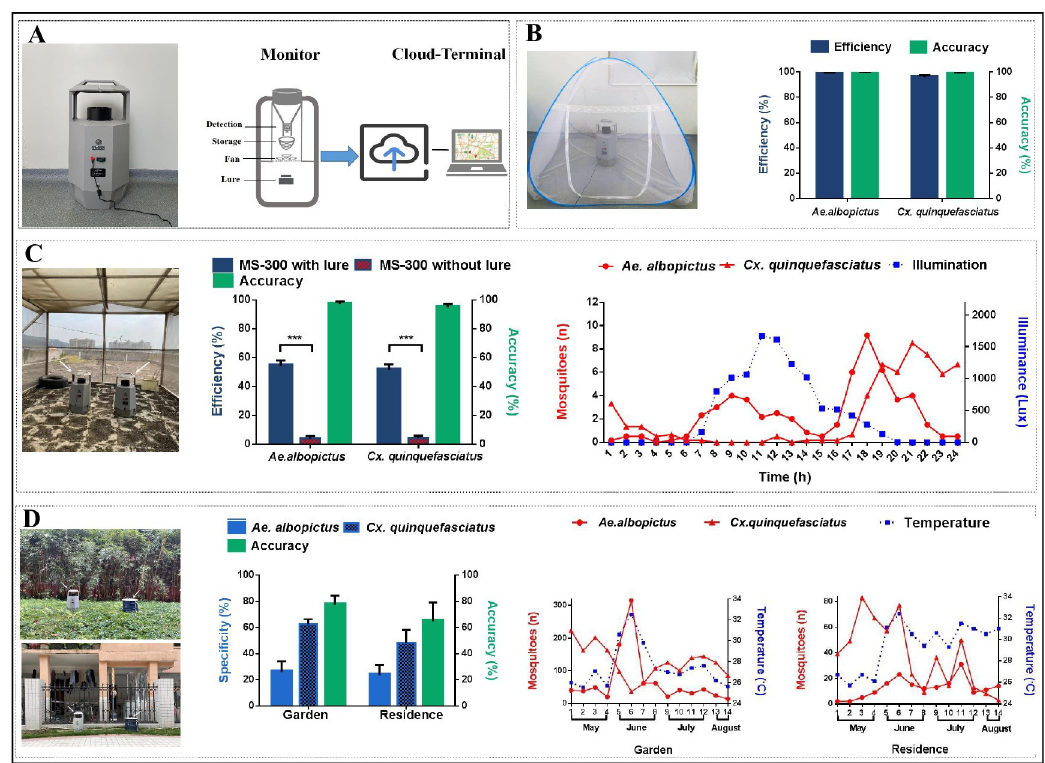
Fig 2. Test of MS-300 monitor in different settings. ( A) Left: Photograph of the MS-300 monitor; Right: Schematic diagram of MS-300 monitor. (B) Test of MS-300 monitor in laboratory. Left: actual laboratory scene; Right: efficiency and accuracy verification of the MS-300 monitor in capturing mosquitoes; the error bars represent 95% confidence intervals (CIs). ( C) Test of MS-300 monitor in semi-field. Left: actual semi-field scene; Center: efficiency and accuracy verification of the MS-300 monitor in capturing mosquitoes; Right: hourly mosquito capture numbers over 24 hours; the error bars represent 95% CIs; ��� , P < 0.001. ( D) Test of the MS-300 monitor in field. Left: actual field scene; Center: specificity of the MS-300 monitor in catching Ae . albopictus and Cx . quinquefasciatus in two sites; Right: weekly variations in the densities of Ae . albopictus and Cx . quinquefasciatus and local temperatures in study sites; the error bars represent 95% CIs.